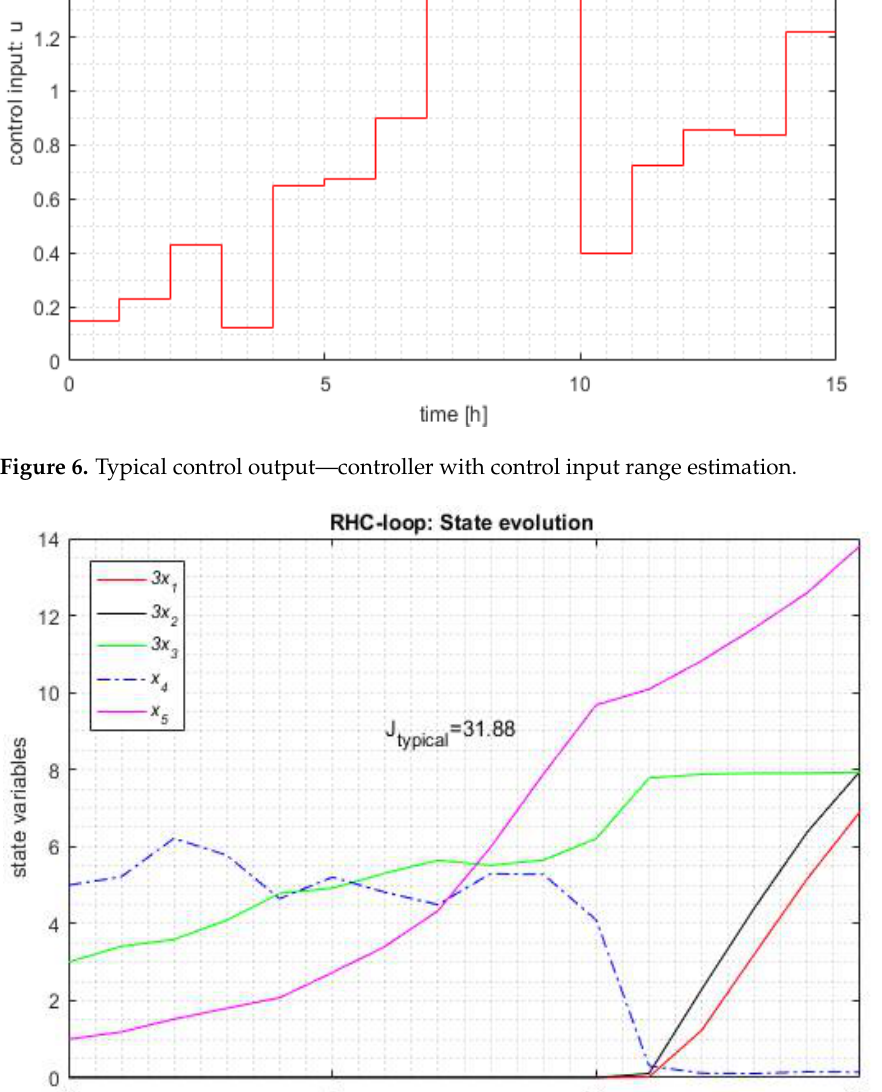
Figure 7. Typical state evolution—controller with control input range estimation.